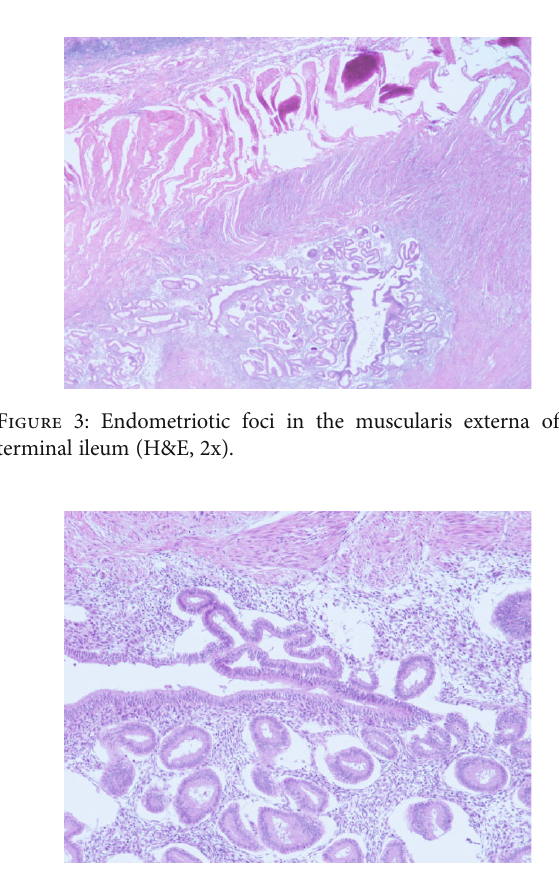
Figure 4: Endometriotic foci in the muscularis externa of the terminal ileum (H&E,